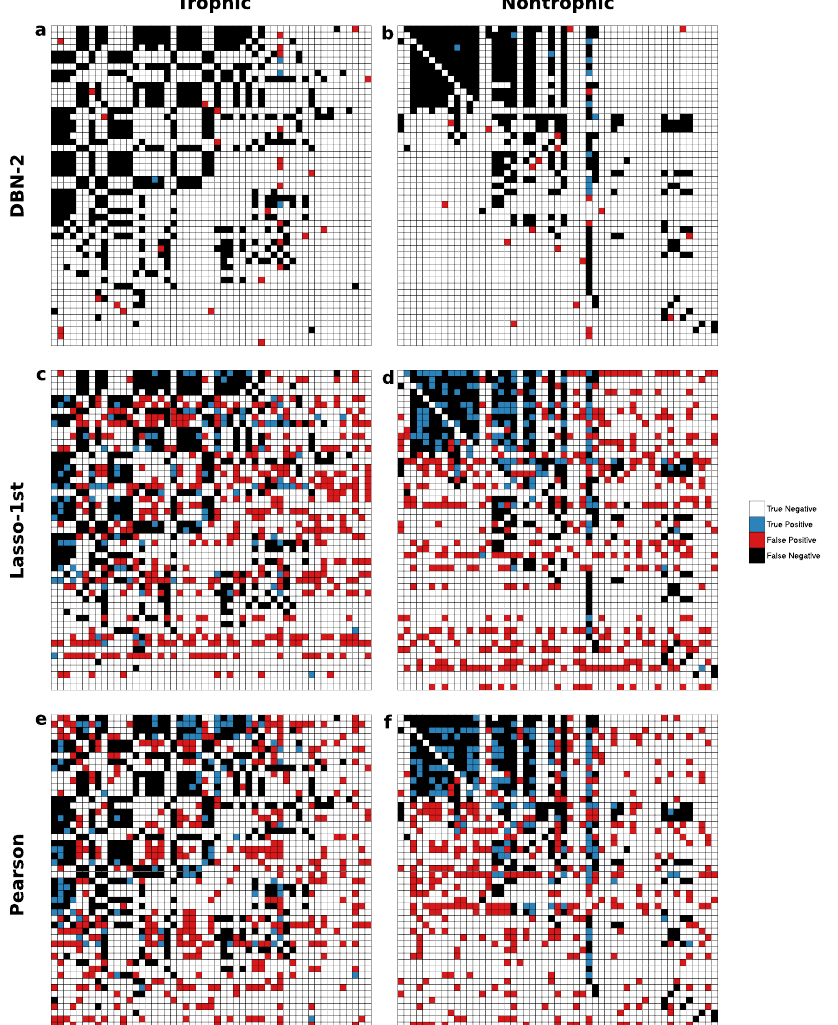
Figure 2. Structural comparison between empirical and model adjacency matrices for the Tatoosh system: ( a ) Trophic and DBN-2, ( b ) Nontrophic and DBN-2, ( c ) Trophic and Lasso-1st, ( d ) Nontrophic and Lasso-1st, ( e ) Trophic and Pearson, and ( f ) Nontrophic and Pearson. White boxes represent the absence of a link in both networks (true negative), blue represents a link present in both networks (true positive), black, a link present in the empirical but not model network (false negative), and red, a link present in the model but not empirical network (false positive).